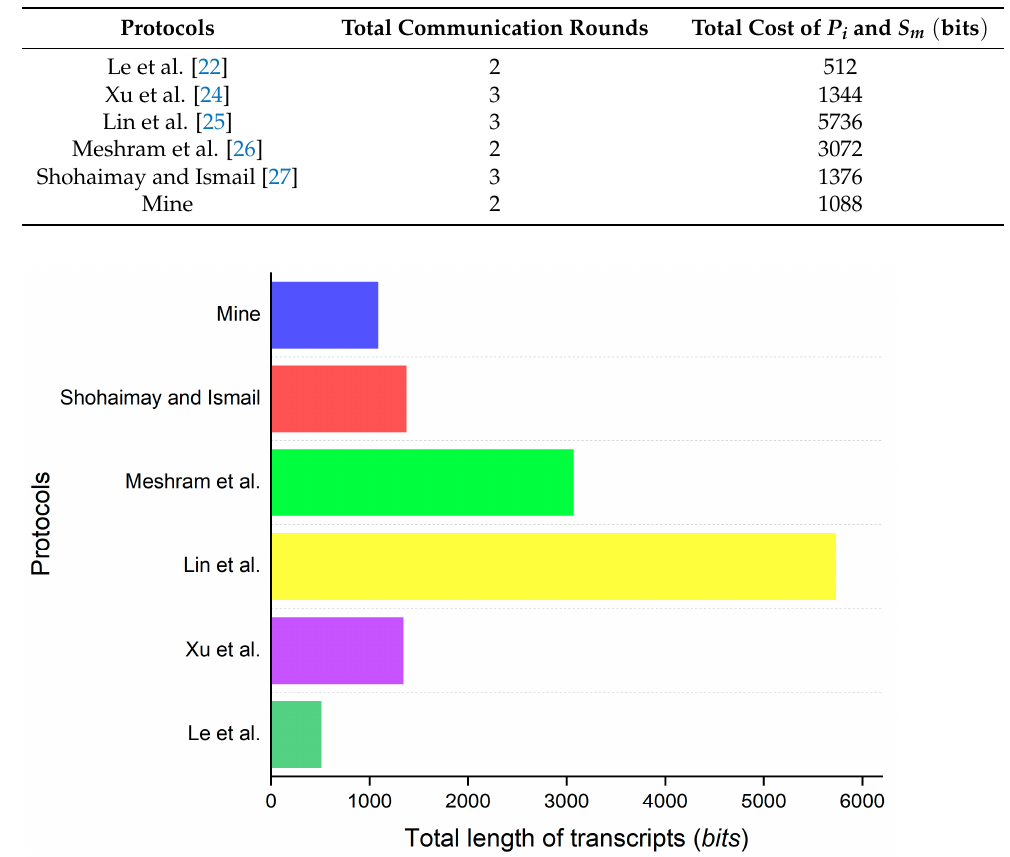
Table 4. Comparison of communication cost.